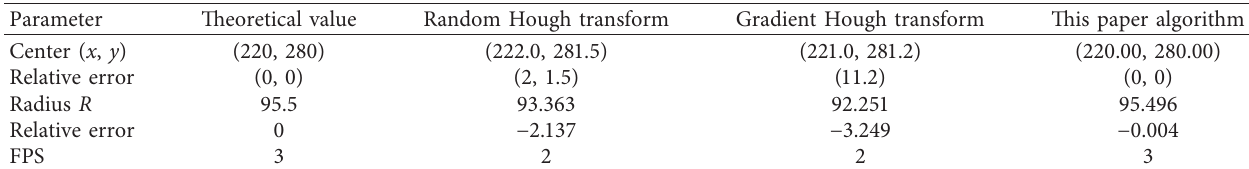
Table 5: The detection results of the circular parameters of the generated